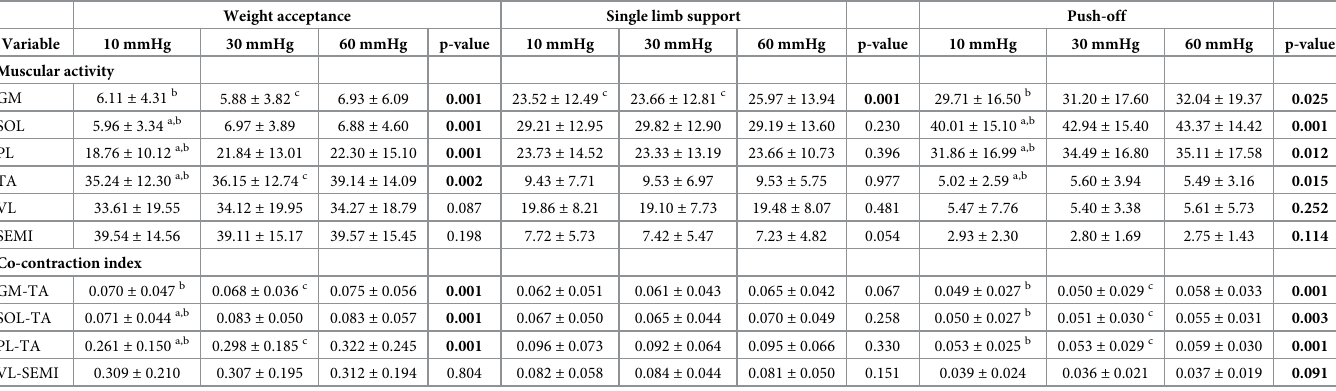
Table 2. Muscular activity for four muscles and co-contraction index for antagonistic pairs when walking with three shoe conditions (mean ±